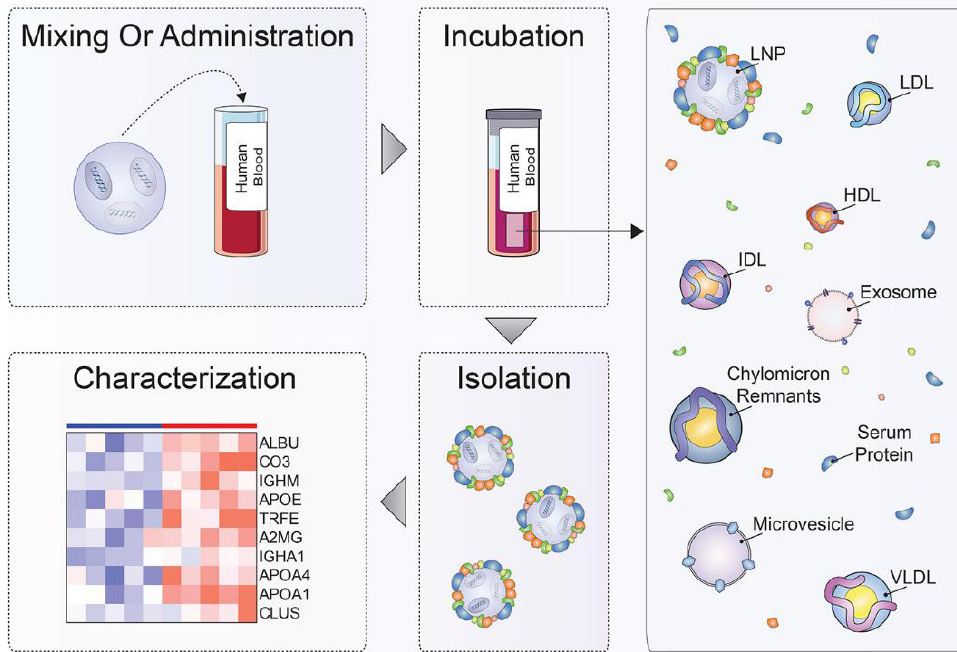
Figure 2. The general research process of the investigation of the protein corona. This process can be divided into four steps, mixing or administration, incubation, isolation, and characterization, and each step has special and important requirements [57]. Copyright 2020, American Chemical Society.